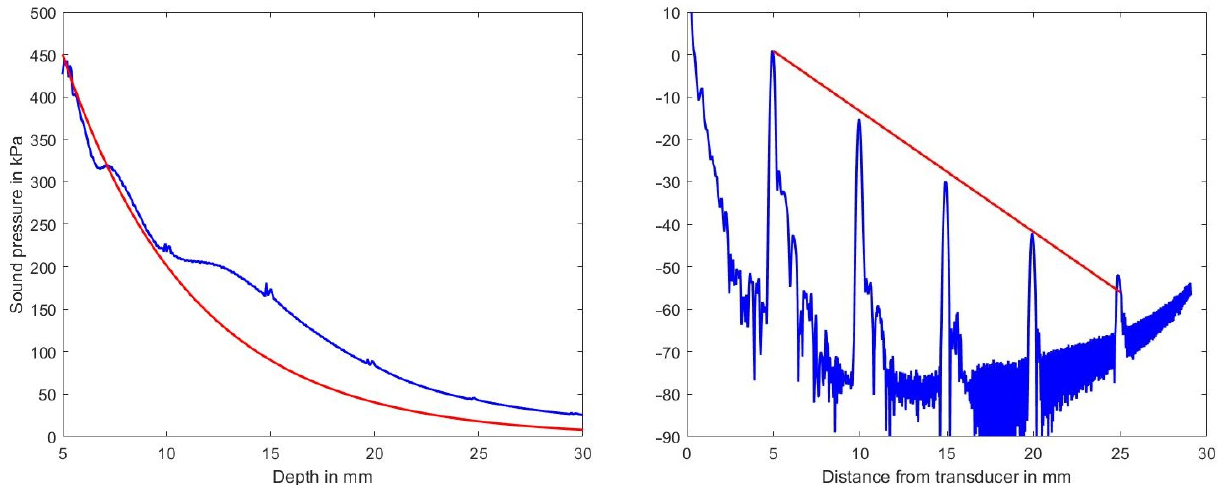
Figure 4. Left diagram: decrease of sound pressure amplitude vs. depth along the center line within the volume in blue and the expected decrease in sound pressure for the assumed attenuation coefficient of 2.3 dB/(MHz cm) in red. Right diagram decrease of sound pressure level vs. depth estimated from a B-mode line (in dB ref. 100 kPa). Indicated in red is the expected decrease in amplitude vs. depth for the chosen attenuation of 2.3 dB/(MHz